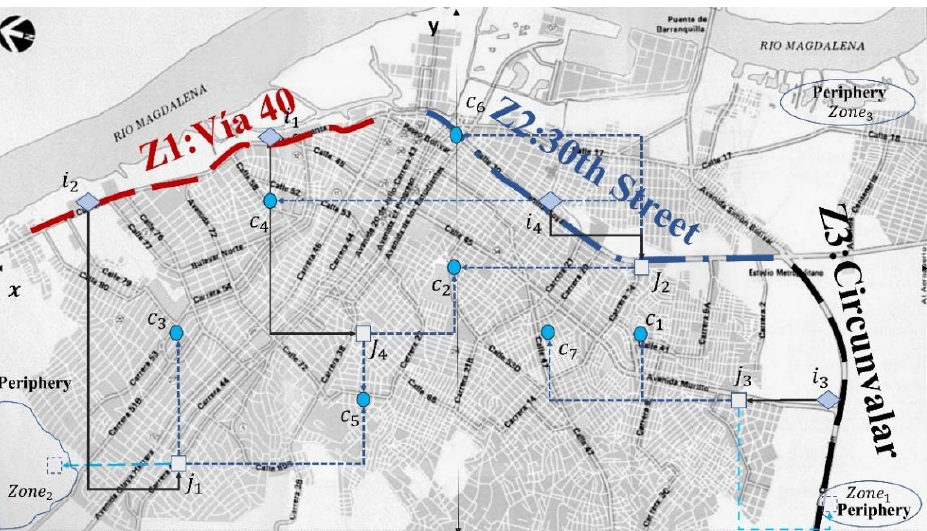
Figure 3. Logistics spaces in the city of Barranquilla, Colombia.